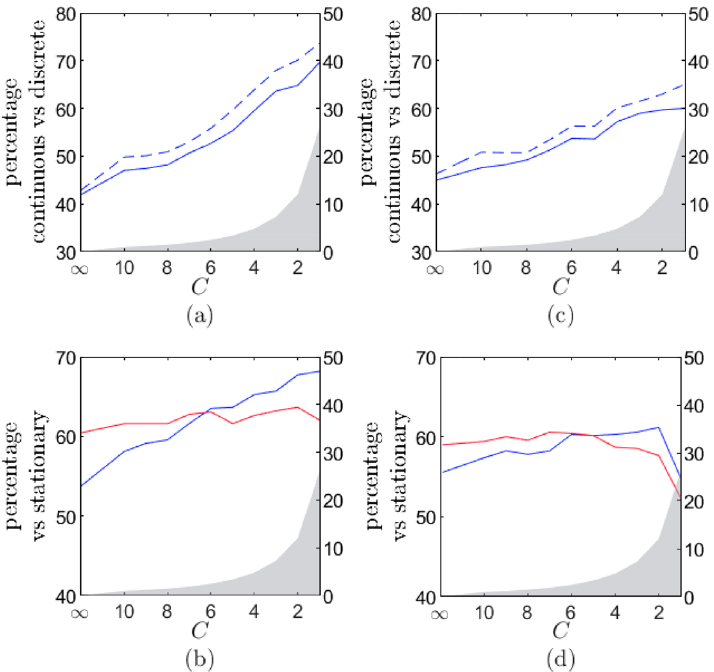
Figure 2. Comparison of the predictive accuracy of several models. In each graph, the x -axis refers to the cutoff criterion for large deviations. From left to right, more observations are removed.The grey shaded area depicts the percentage of data points that are on average removed in function of the critical value (see rightmost y -axis). The critical value C = ∞ corresponds to the case where no data are removed. The y -axis refers to the model comparison. ( a ) Comparison of the basic OU vs the basic VAR(1) model. The solid line shows the percentage of time series for which the basic OU model has a better predictive accuracy than the basic VAR(1) model as a function of the critical value C for removing large deviating speeds. The dashed line shows the same, but is based on a subset of time series for which either the VAR(1) or OU model outperformed its stationary variant (or both). ( b ) The percentage of time series for which the OU outperforms its stationary distribution (blue line) and the same for the VAR(1) model (red line). Panels ( c ) and ( d ) are equivalent to panels ( a ) and ( b ), except that they contain the results pertaining to the models with measurement